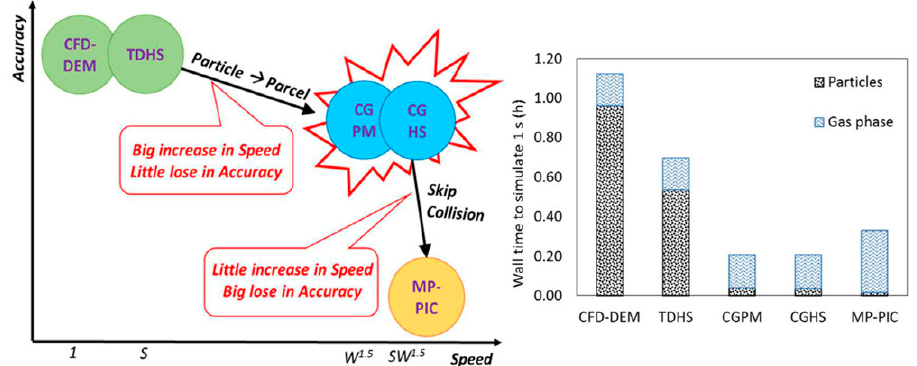
Figure 12. Schematic concept of the coarse-grain hard-sphere (CGHS) model and performance improvement comparison with other approaches for the simulation of a small-scale fluidized bed. Reprinted with permission from Reference [88]. Copyright (2017) American Chemical Society.